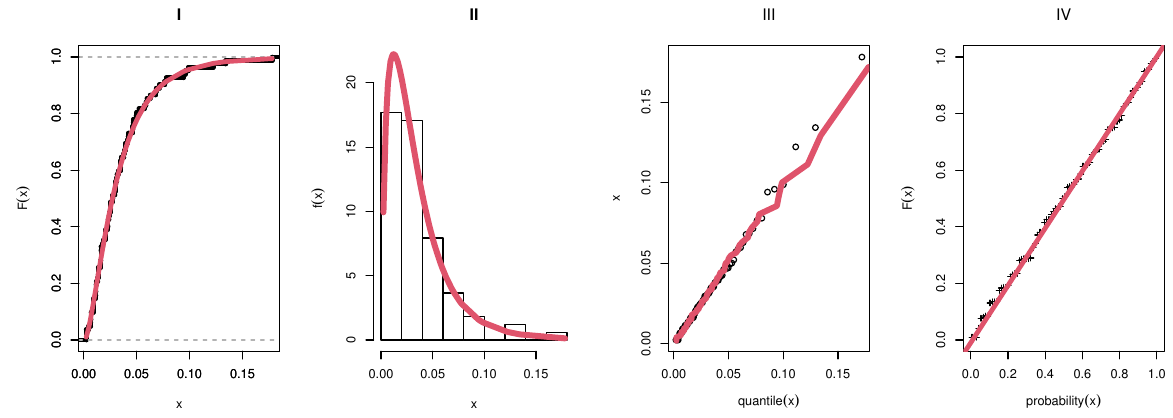
Figure 6. Fitting of ( I ) ecdf, ( II ) epdf, ( III ) QQ and ( IV ) PP plots for plots for the COVID-19 data.